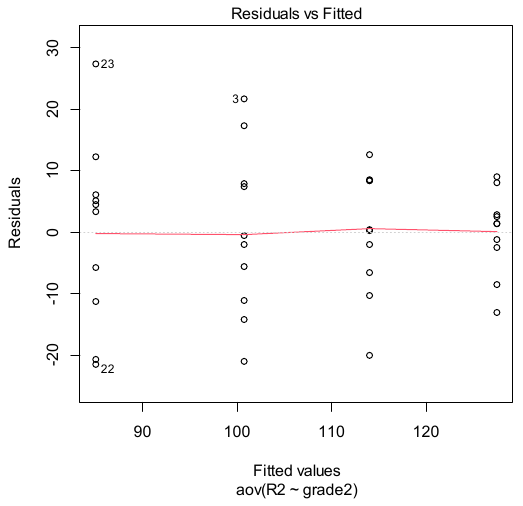
Figure 8. Residuals vs. fitted from ANOVA in DETAX material case.